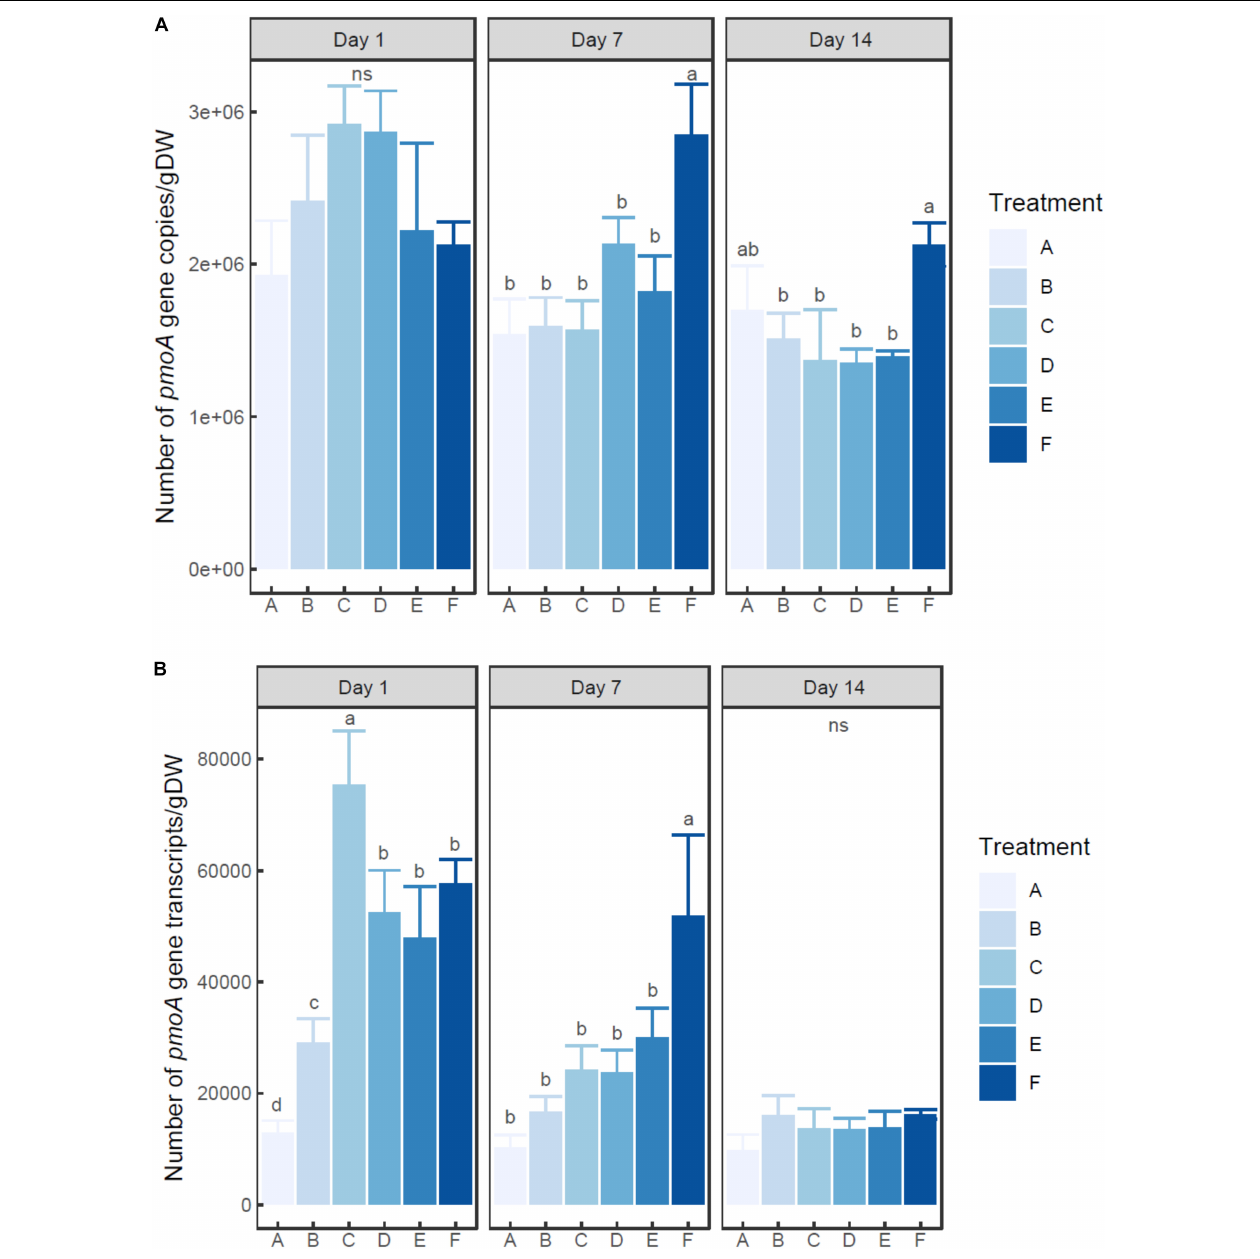
FIGURE 2 | Changes of pmoA gene (A) and transcript (B) abundance in the microcosms with different treatments. Error bar indicates standard deviation ( n = 3). Asterisk indicates the significance between experiment group and control group ( P < 0.05). ‘ns’ indicates no significant difference among treatments at a given